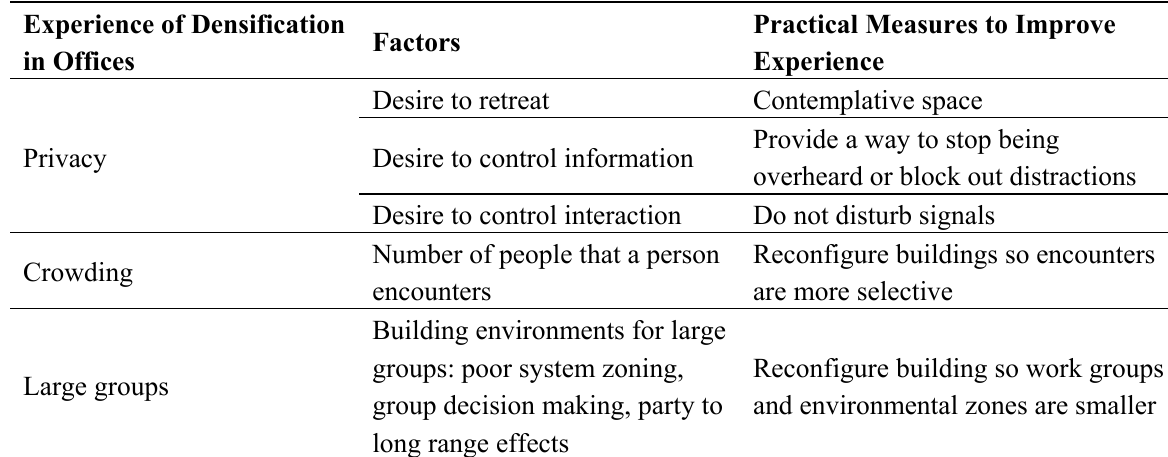
Table 2. The different ways occupant density and spatial constraints are